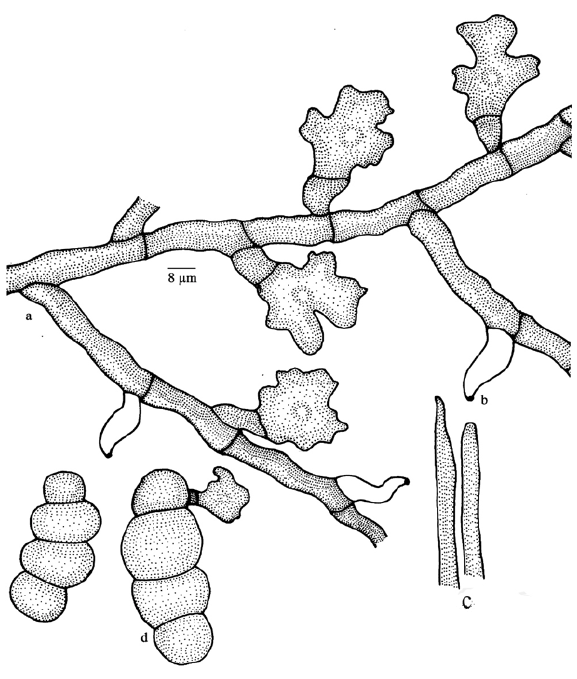
Figure 62. Meliola celastrigena a - Appressorium; b - Phialide; c - Apical portion of mycelial setae; d - Ascospores